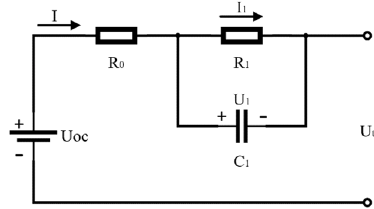
Figure 1. First ‐ order RC circuit model. Figure 1. First-order RC circuit